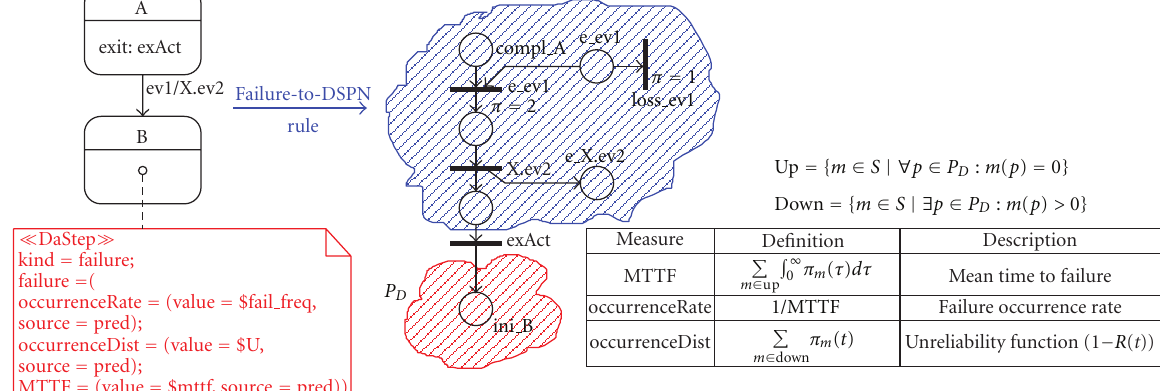
Figure 5: Definition of DSPN dependability measures.